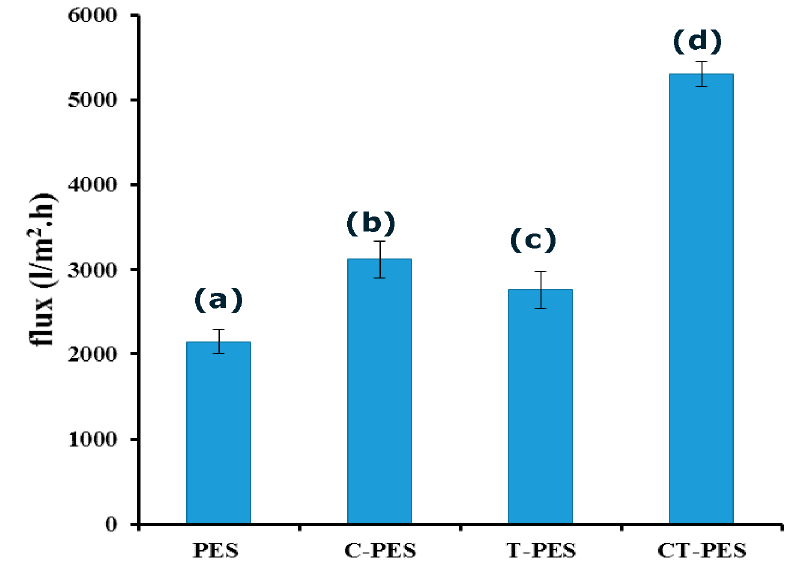
Figure 5. Graph showing membrane flux of the (a) pure polyethersulfone (PES) membrane, (b) cannabinoid embedded polyethersulfone (C-PES) membrane, (c) terpene embedded polyethersulfone (T-PES) membrane, and (d) cannabinoid and terpene embedded polyethersulfone (CT-PES) membrane.